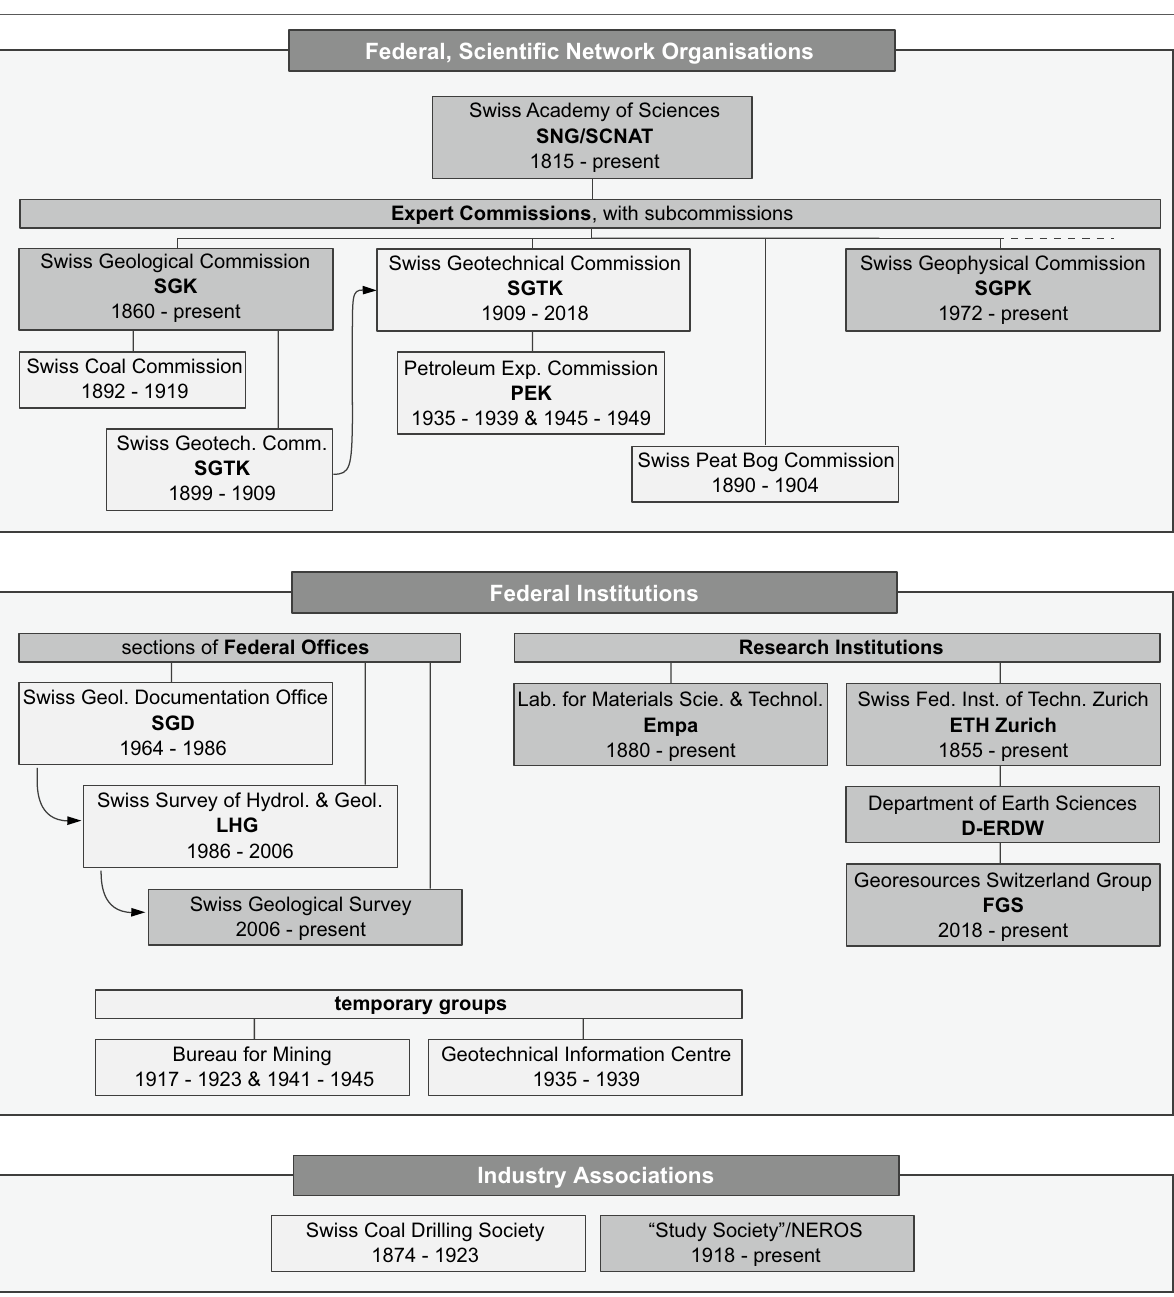
Fig. 3 Organisational diagram of the georesources-related Swiss institutions discussed in the text. The vertical lines between boxes indicate sub-units. For an illustration in chronological order, the full list of the names, abbreviations and colours see Fig. 2. Empa: Eidgenössische Materialprüfungs- und Forschungsanstalt, ETH: Eidgenössische Technische Hochschule Zürich, D-ERDW: Departement Erdwissenschaften. Note that only those Swiss institutions are presented here which are discussed in the text. For an illustration in chronological order and the full list of the names see Fig.